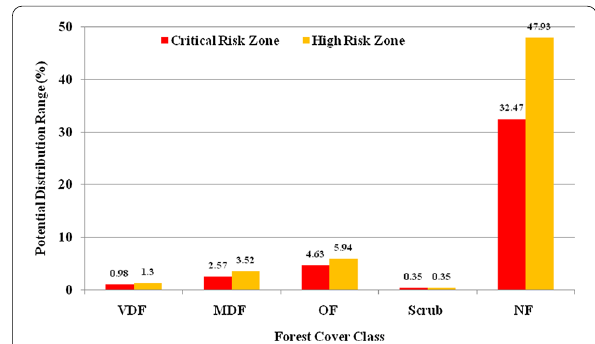
Fig. 9 Potential distribution range of L. camara in different forest cover classes under high risk zone (AUC value: 0.50–0.70), and critical risk zone (AUC value > 0.70) in Jharkhand under the current climate scenario. Chart demonstrates that the majority of the distribution occurs under the non-forest (NF) and open forest (OF) area